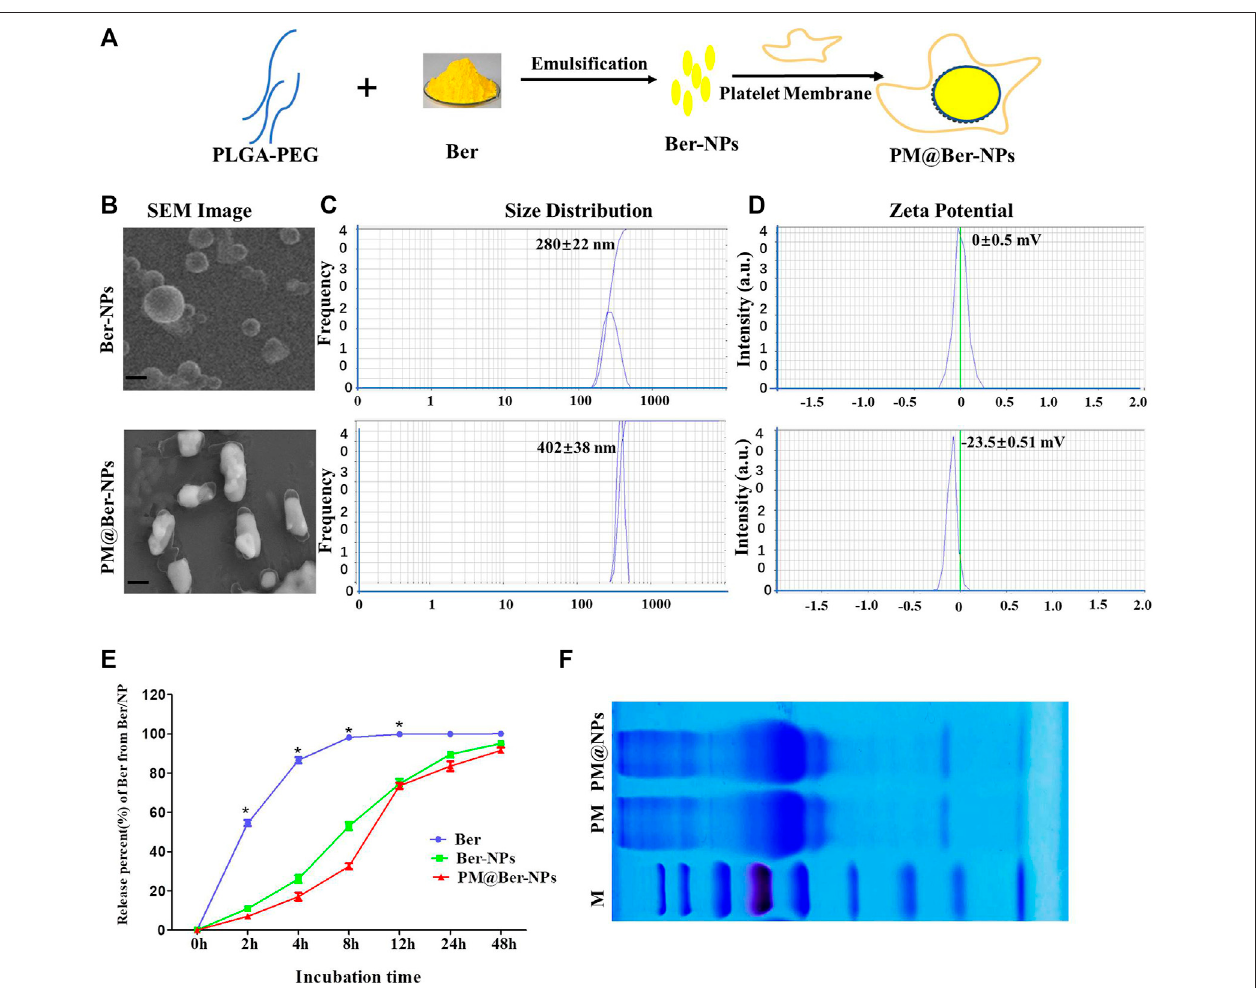
FIGURE1| CharacterizationofBer-loadedNPs. (A) Schemeofpreparationofbiomimetic-basedplatelet-cellmembrane-coatednanoparticles(PM@Ber-NPs). (B) Scanningelectronmicroscope(SEM)imageofBer-NPsandPM@Ber-NPs.Scalebar (cid:1) 100 nm. (C) Meansizeand (D) zetapotentialsofBer-NPsandPM@Ber-NPs. (E) In vitro release kinetics of berberine from nanoparticles (NPs) in PBS (0.01 M, PH (cid:1) 7.4). (F) SDS-PAGE protein analysis of platelet membrane (PM) and PM@NPs. * p < 0.05.